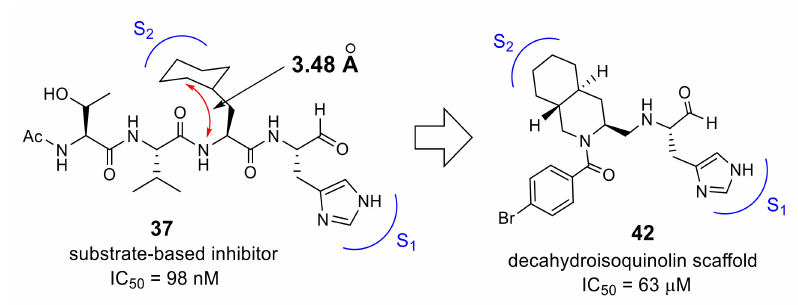
Figure 13. Design of a decahydroisoquinoline sca ff